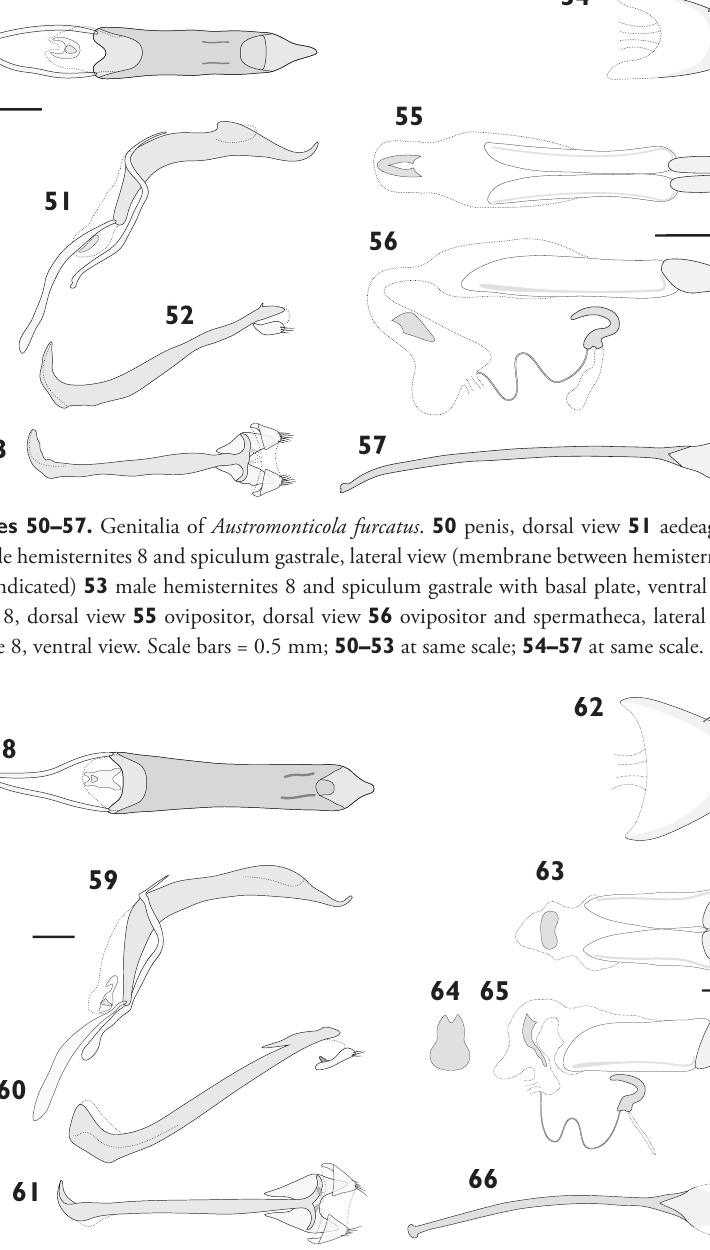
Figures 58–66. Genitalia of Austromonticola inflatus . 58 penis, dorsal view 59 aedeagus, lateral view 60 male hemisternites 8 and spiculum gastrale, lateral view (muscles between hemisternites 8 and basal plate indicated) 61 male hemisternites 8 and spiculum gastrale with basal plate, ventral view 62 female tergite 8, dorsal view 63 ovipositor, dorsal view 64 bursal sclerite, anterior view 65 ovipositor and spermatheca, lateral view 66 sternite 8, ventral view. Scale bars = 0.5 mm; 58–61 at same scale; 62–66 at same